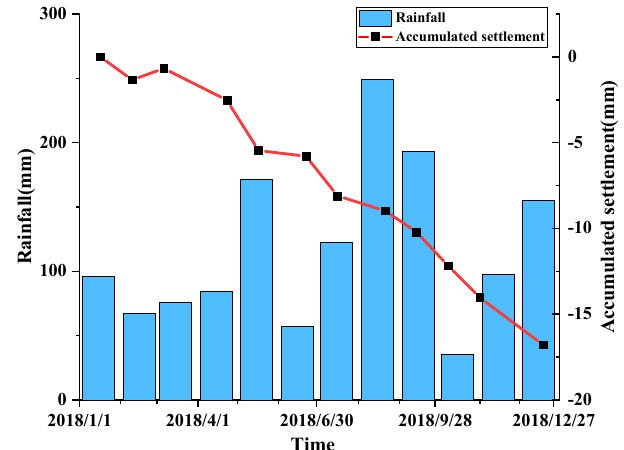
Figure 8. QX1Comparison of Precipitation and Subsidence of National Meteorological Station.